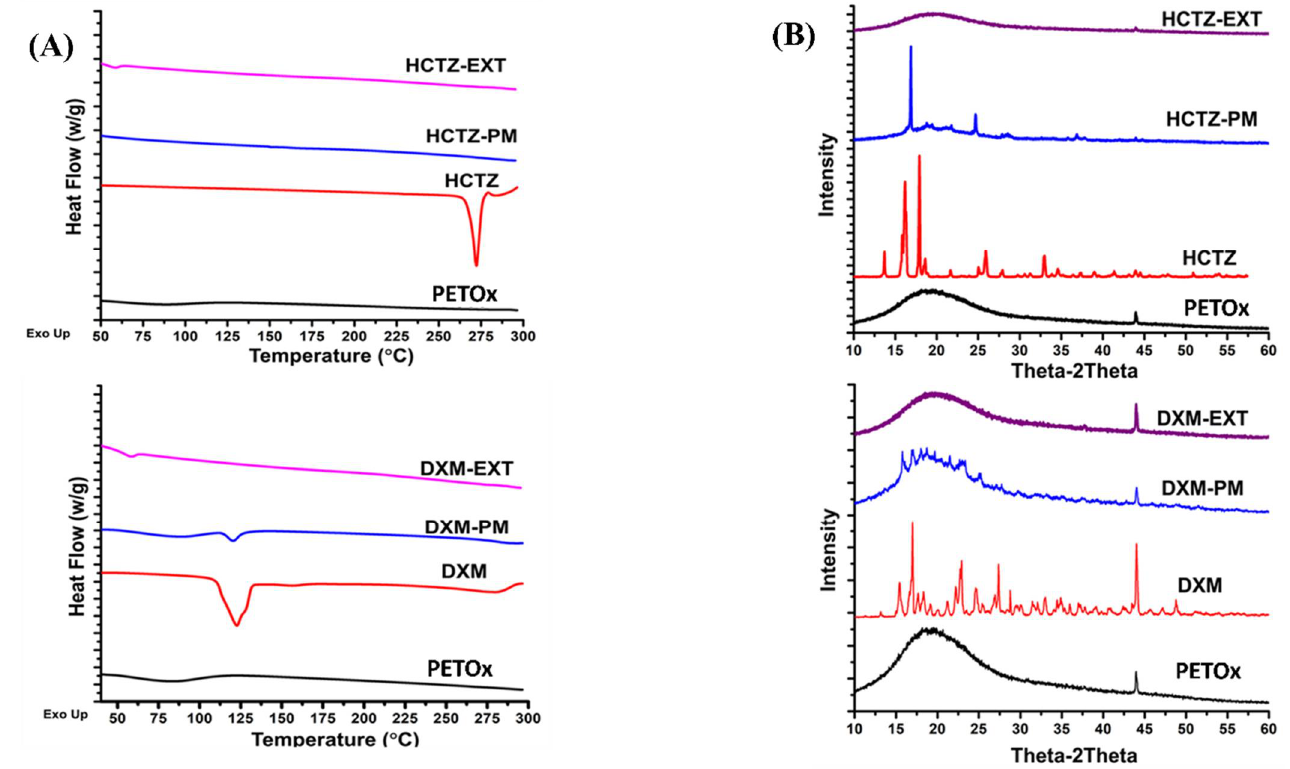
Figure 4. Solid State Characterization of the drug, drug-PETOx physical mixtures, and crushed drug-loaded extrudates by: ( A ) Differential Scanning Calorimetry; ( B ) X-ray powder drug-loaded extrudates by: ( A ) Differential Scanning Calorimetry; ( B ) X-Ray powder diffraction.